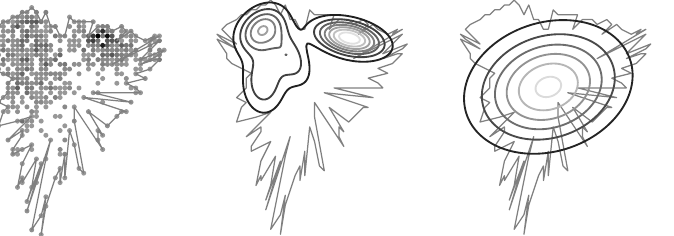
Figure 13. Initialization of Gaussian Mixture from cell’s raster map. The original cell’s polygon as well as the RF signal samples are shown on the left plot. The resulting mixture of Gaussian is shown on middle one. The right one illustrates the RF signal coverage distribution derived from the polygon